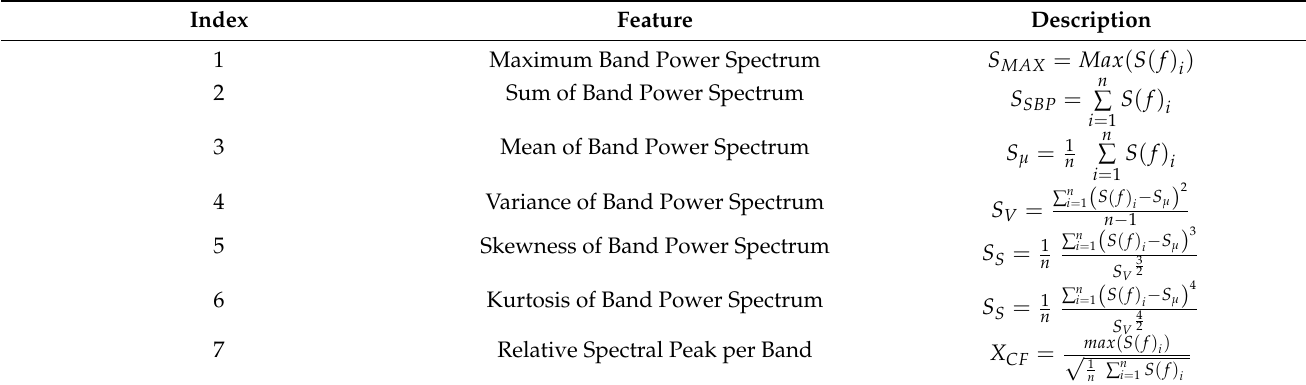
Table 3. Frequency-domain features for commonly observed sensor signals for machining according to